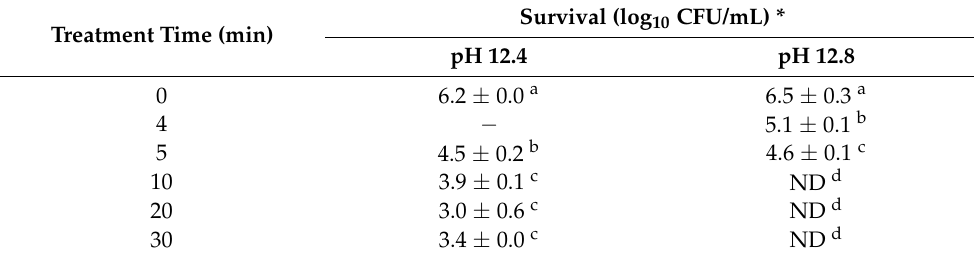
Table 3. Antibiofilm effects of alkaline treatment (NaOH) on the biofilms of C. jejuni ATCC 29428 on filter